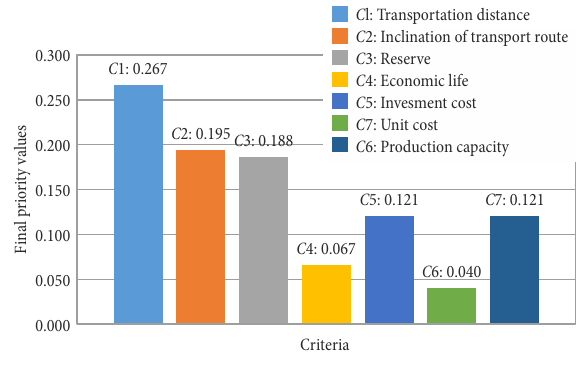
Fig. 5. Priorities of decision criteria